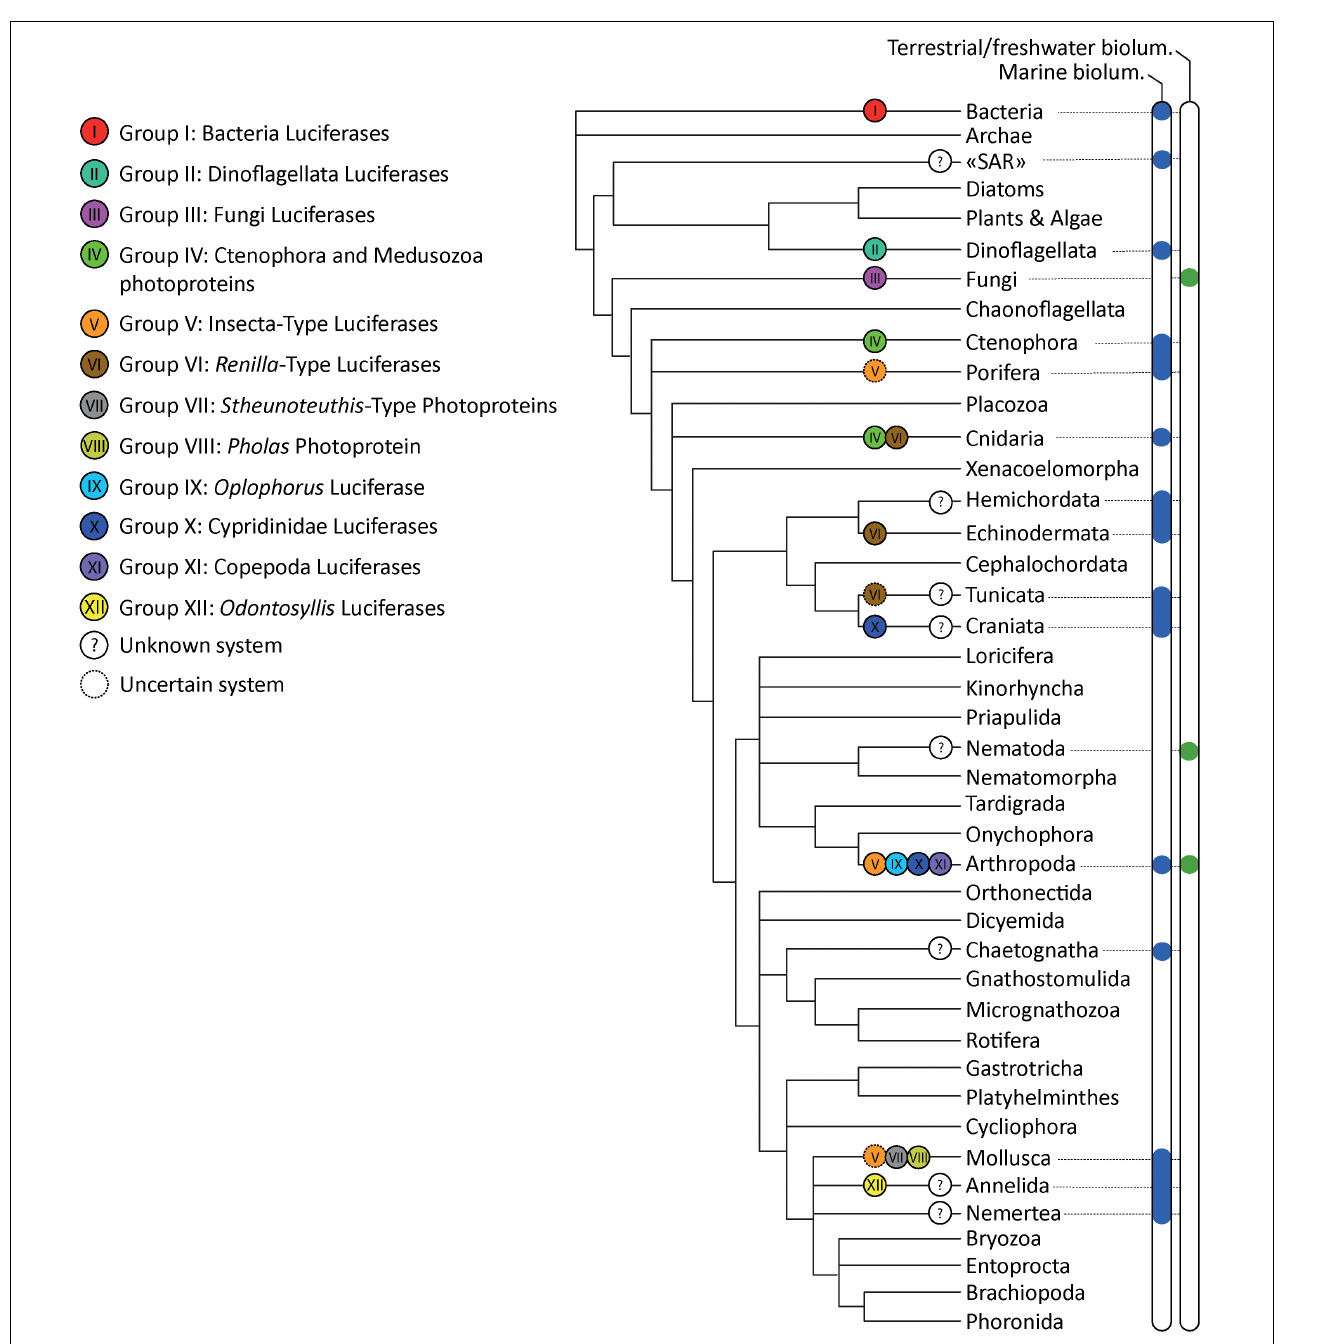
FIGURE 3 | Bioluminescence tree of life annotated with the corresponding bioluminescent protein Group. Distribution of terrestrial and aquatic organisms is based on Lau and Oakley (2020) and Haddock et al. (2010). Phylogenetic tree based on Giribet and Edgecombe